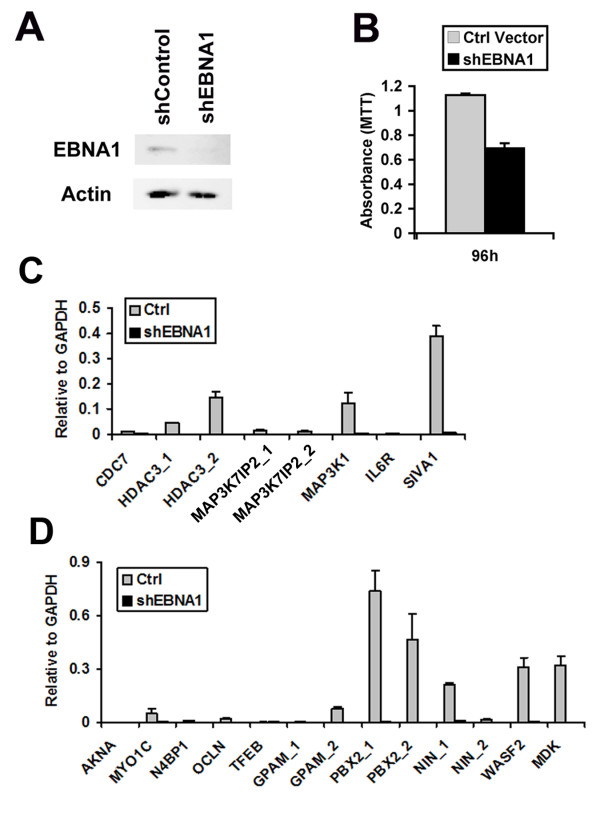
shRNA depletion of EBNA1 causes a loss of transcription of several genes with EBNA1 binding sites. A) Western blot showing EBNA1 (top panel) and loading control Actin (lower panel) in Raji cells transfected with plasmid expressing shControl or shEBNA1. B) Raji cells transfected with shControl or shEBNA1 plasmids were selected by GFP positive FACS, and then assayed at 96 hrs post-infection for absorbance in the presence of metabolic activity indicator MTT. C) shControl (grey) or shEBNA1 (black) infected Raji cells were assayed by RT-PCR for genes CDC7, HDAC3, MAP3K7IP1, MAP3K, IL6R, or SIVA1. D) Same as in panel C, except at different cellular genes, as indicated in the legend. For genes with more than one promoter start site, additional primer pairs were used to measure each alternative transcript, as indicated by _1 or _2. All RT-PCR was normalized with GAPDH.